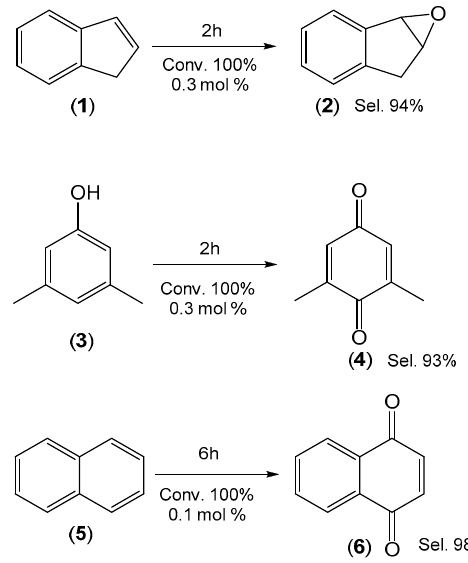
Figure 5. Catalytic oxidation of aromatic compounds in the system [Fe(TPFPP)Cl]/EtOH/H 2 O 2 .